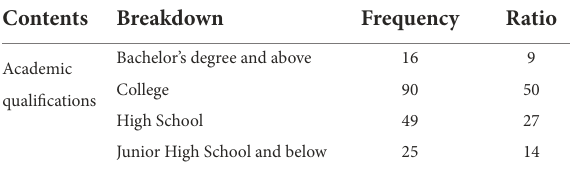
TABLE 2 Survey on the educational attainment of courier